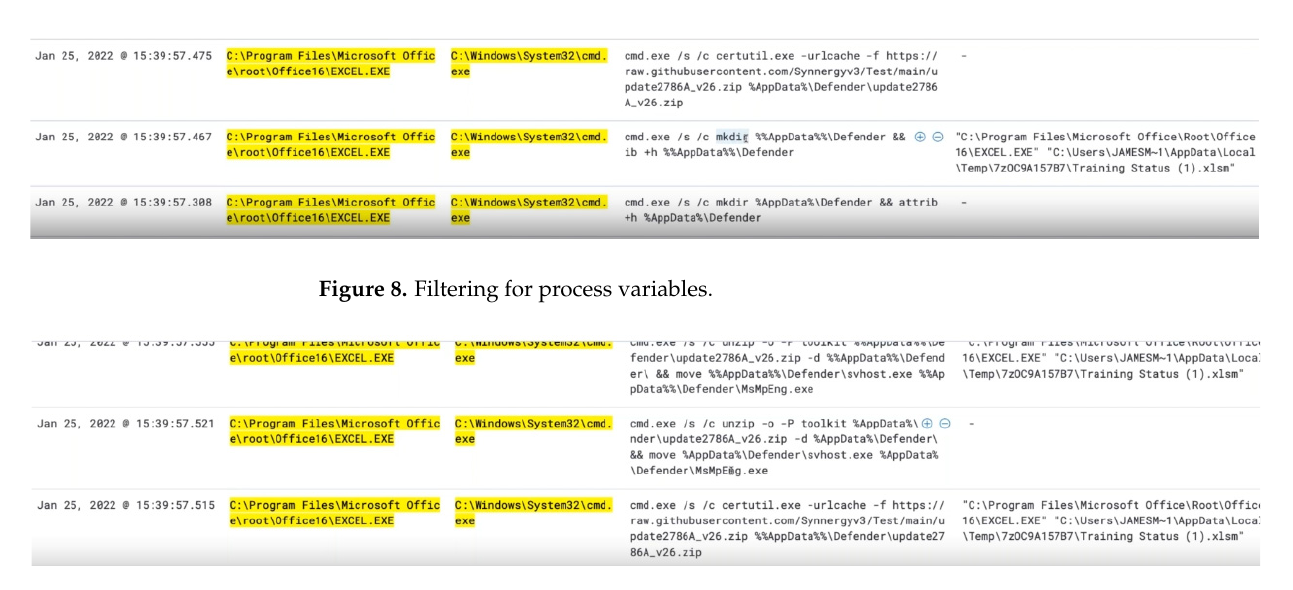
Figure 8. Filtering for process variables.